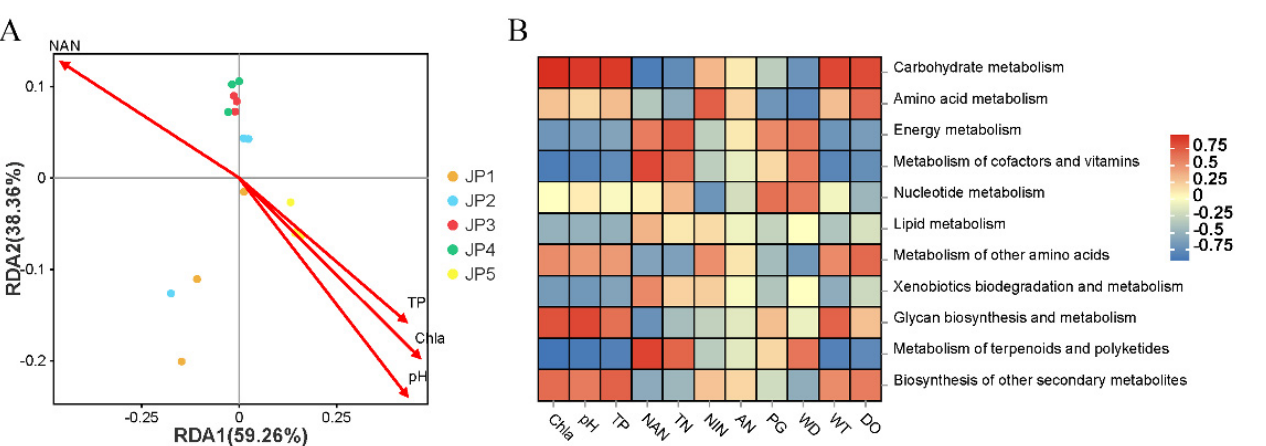
10 of 16 Figure 6. Correlation between physicochemical factors and microbial genera. ( A ) Redundancy anal- ysis (RDA) depicted the relationship between the top four environmental indicators and the com- position of water microbiota among five groups. ( B ) Correlation heatmap between microbial abun- dance and all physicochemical factors. Statistical analyses of correlations were performed using Pearson correlation analysis.